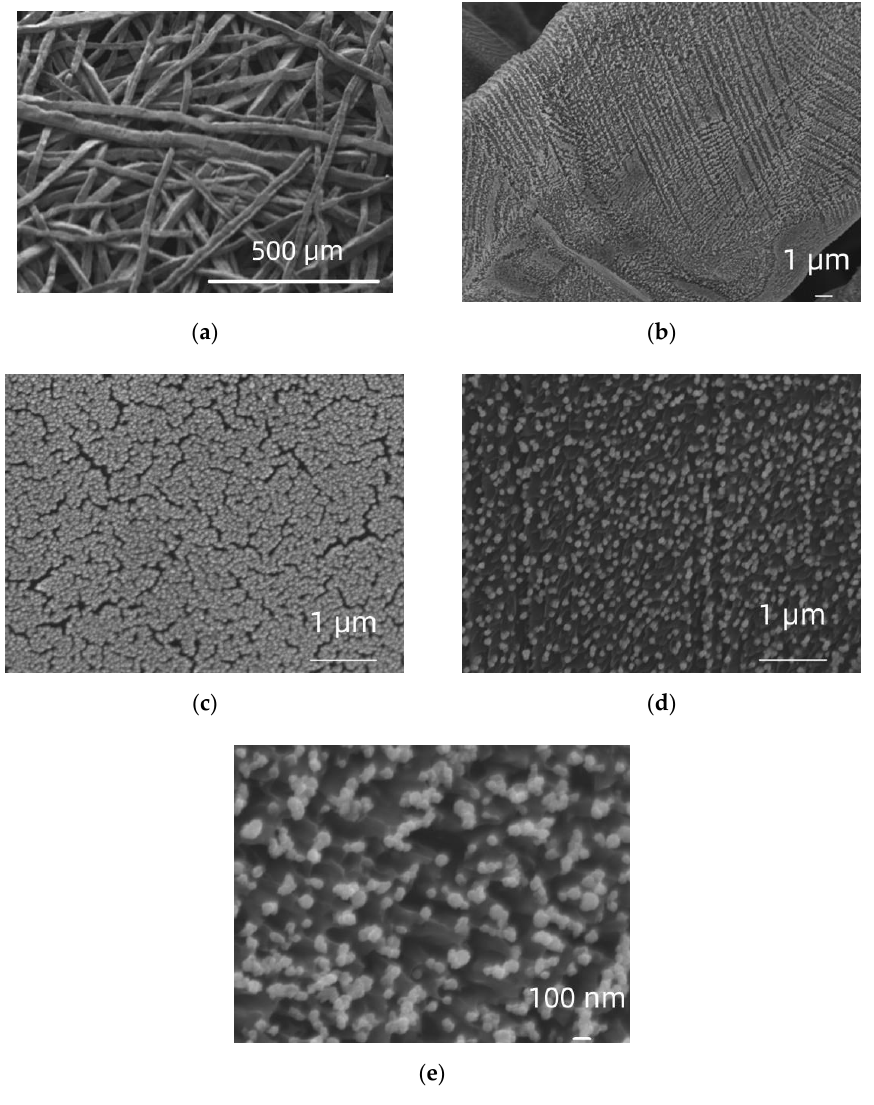
Figure 2. SEM micrographs of a Pt/Ti felt at a magnification of ×100 ( a ), ×4.5k ( b ), ×20k ( c ) + ( d ) and ×50k ( e ) .